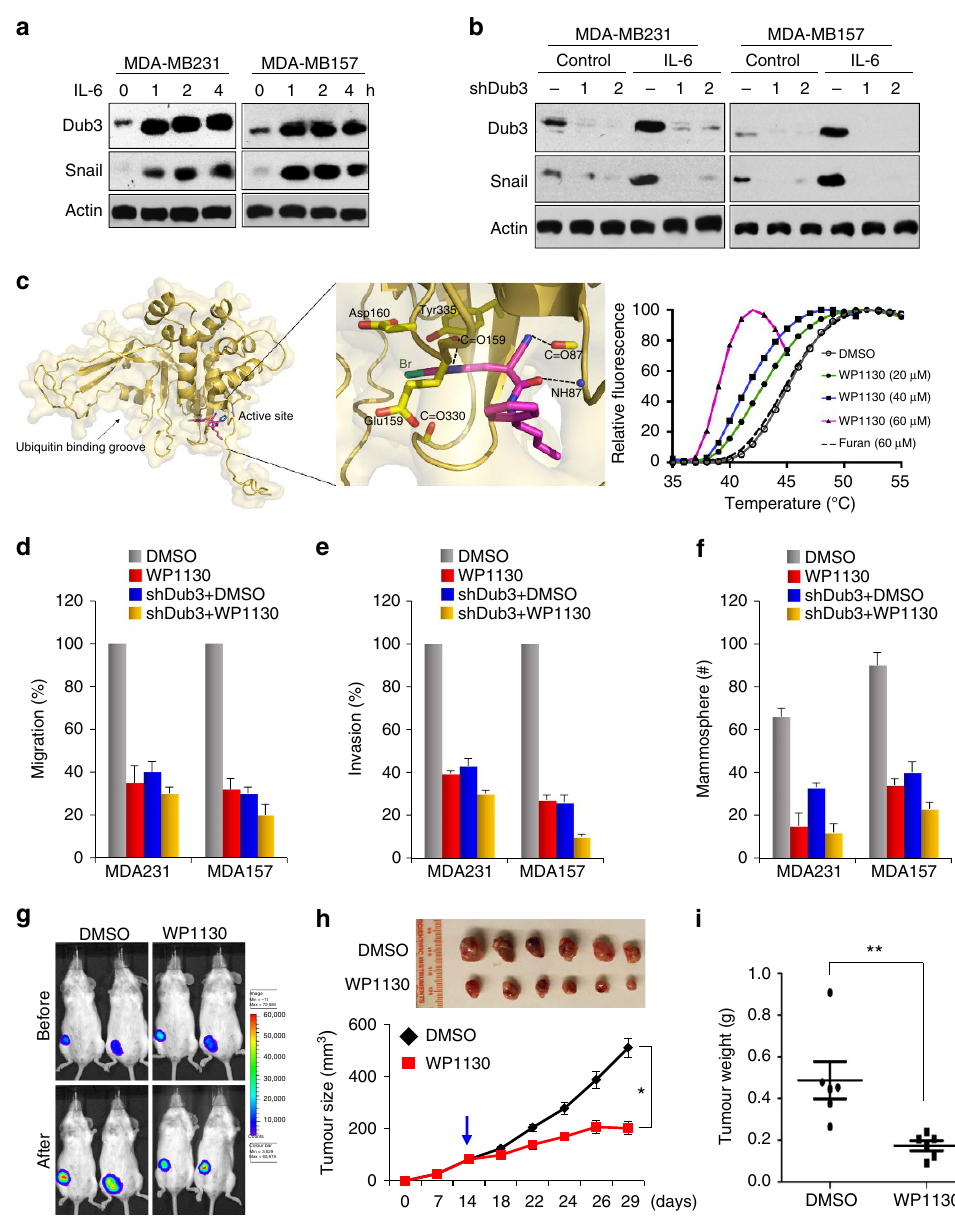
Figure 7 | Dub3 is critical for IL-6 induced Snail1 stabilization. ( a ) MDA-MB157 and MDA-MB231 cells were serum starved for 24h, then treated with IL-6 for different time intervals. Expression of endogenous Snail1 and Dub3 were assessed by western blot. ( b ) MDA-MB231 and MDA-MB157 cells with Dub3-knockdown by two individual shRNAs or vector control were serum starved for 24h followed by IL-6 treatment for 4h. Expression of endogenous Snail1 and Dub3 were assessed by western blot. ( c ) A predicted model structure of Dub3 and WP1130 complex. The Dub3-UCH domain structure (yellow) is shown as ribbons while WP1130 (magenta) and the catalytic triad residues (sky blue: Cys89, His334, and Asp350) are shown as sticks. The inhibitor molecule binds to the opening surface of the active site where the ubiquitin cleavage site is presented. A zoom-up view of the interaction network is shown in the inset where the interacting residues are represented by sticks. These interactions include hydrogen bonds with backbone atoms (dotted lines) and potential halogen (Br) bonding interactions with the neighbouring electronegative atoms. Normalized melting curves (Right panel) depicting dose- dependent shifted thermal stability of Dub3 by WP1130 (coloured lines) from that of the apo protein (grey line), but not by a furan compound (dotted line; negative control). Tm for apo protein and D Tm values for compound-bound proteins are indicated. ( d ) MDA-MB231 and MDA-MB157 cells stably expressing control vector or Dub3 shRNA were treated with 0.5 m M WP1130 for 24h and analysed for cell migration using a wound healing assay. Graphic representation is the percentage of migration (mean ± s.e.m. in three separate experiments). ( e ) MDA-MB231 and MDA-MB157 cells stably expressing control vector or Dub3 shRNA were treated with 0.5 m M WP1130 for 4h and analysed for cell invasion. Graphic representation is the percentage of invasive cells (mean ± s.e.m. in three separate experiments in duplicates). ( f ) MDA-MB231 and MDA-MB157 cells stably expressing control vector or Dub3 shRNA were treated with 0.5 m M WP1130 and analysed for tumorsphere-formation. Graphic representation is the number of tumorspheres (mean ± s.e.m. in three separate experiments). ( g , i ) MDA-MB231-luc cells were injected into the mammary fat pad of SCID mice. When tumours reached 100mm 3 , mice were divided into two groups and treated with WP1130 (50mgkg (cid:2) 1 ) or solvent, respectively. Tumour size was recorded by bioluminescence imaging before or after 2-week of treatment ( g ). Tumour growth ( h ) and weights ( i ) were measured. Presented data are the mean ± s.d. from six mice. *P r 0.05, ** P r 0.01; Student’s t